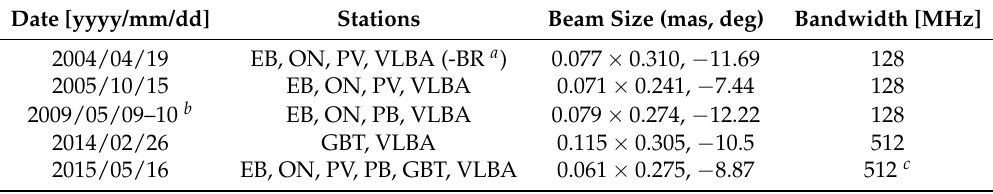
Table 1. Summary of the observations and the data. Station abbreviations are: EB—Effelsberg, ON—Onsala, PV—Pico Veleta, PB—the phased Plateau de Bure interferometer, GBT—the Green Bank Telescope, and VLBA—the 3 mm VLBA stations (i.e., without Hancock and Saint Croix). The restoring beam sizes are from the natural weighting. (a) Brewster was not available; (b) The observations in 2009 were conducted in full-track mode over two consecutive days; (c) PB is limited to a bandwidth of 256 MHz due to 1Gbps of limited maximum data recording